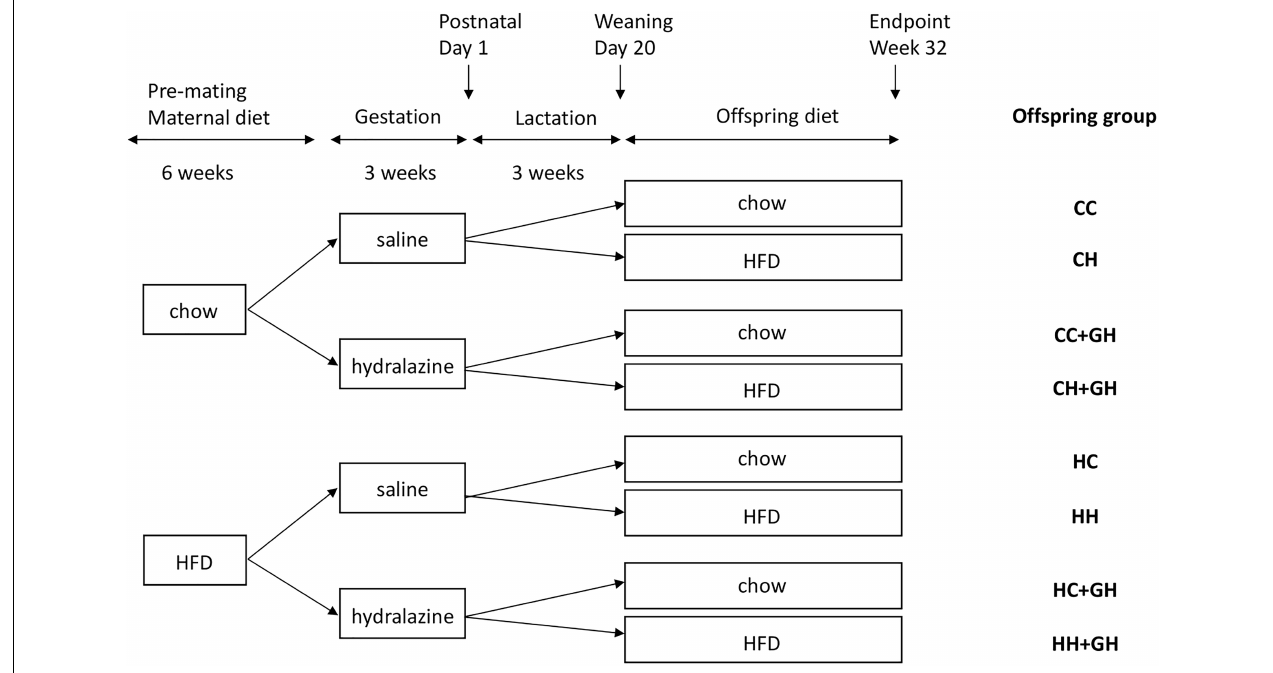
FIGURE 1 | Schematic representation of the animal model used in this study. Mothers continued the allocated diet during gestation and lactation. HFD, high fat diet; CC, control offspring; CH, obese offspring of lean mothers; CC + GH, control offspring exposed to gestational hydralazine; CH + GH, obese offspring of lean mothers with gestational hydralazine; HC, lean offspring of obese mothers; HH, obese offspring of obese mothers; HC + GH, lean offspring of obese mothers with gestational hydralazine; HH + GH, obese offspring of obese mothers with gestational